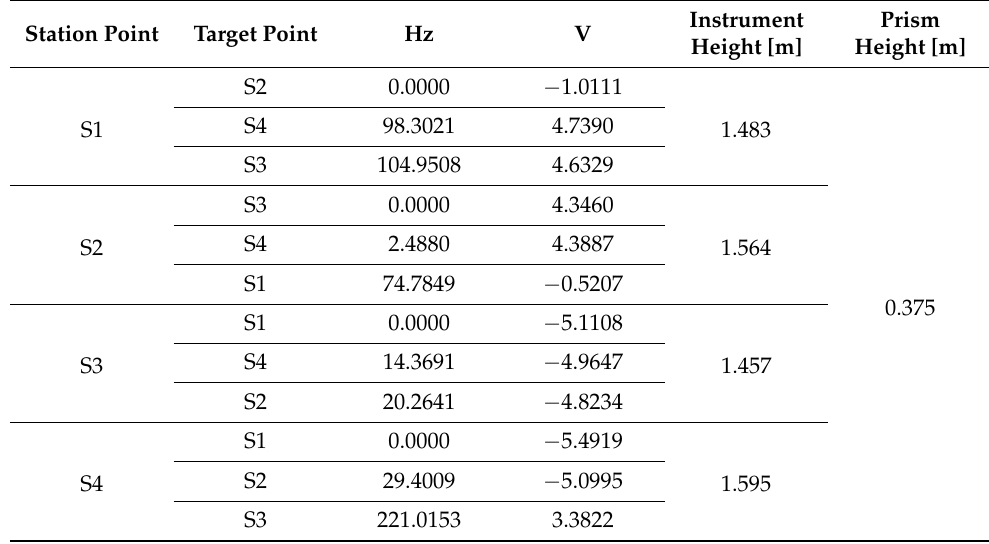
Table A1. The base angular observations (2017).